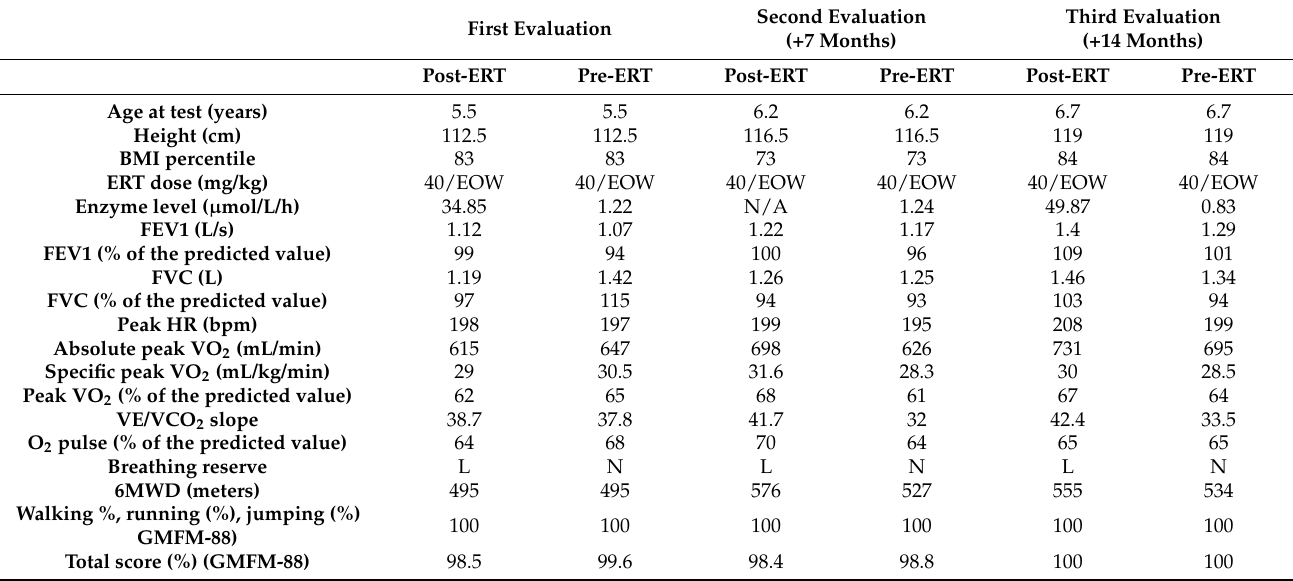
Table 2. Patient 1.